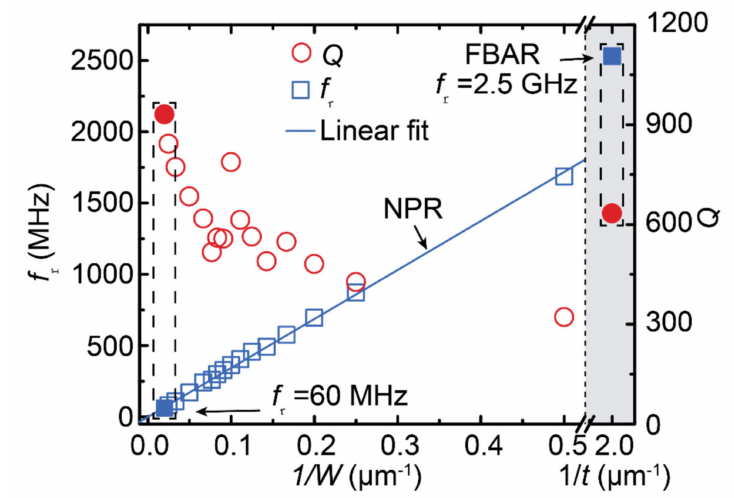
Figure 12. Measured resonance frequency, f r , and Q-factor as a function of 1/ w ( w is width) for NPR devices and 1/ t ( t is thickness) for FBAR devices. By using a simple device geometry design, we can achieve a wide frequency band from tens of MHz to tens of GHz on only one chip. Reprinted with permission from ref. [47]. Copyright 2021 Springer Nature Publishing.